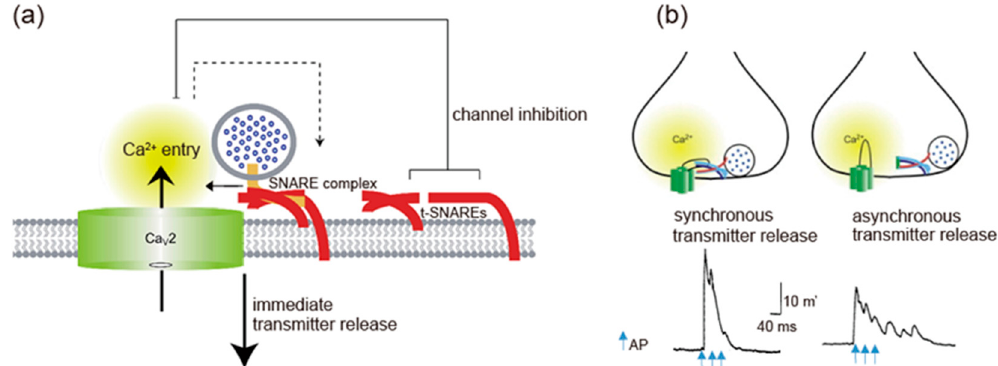
Figure 3. Spatial regulation of transmitter release by the I-II loop interaction with SNAREs. (a) The